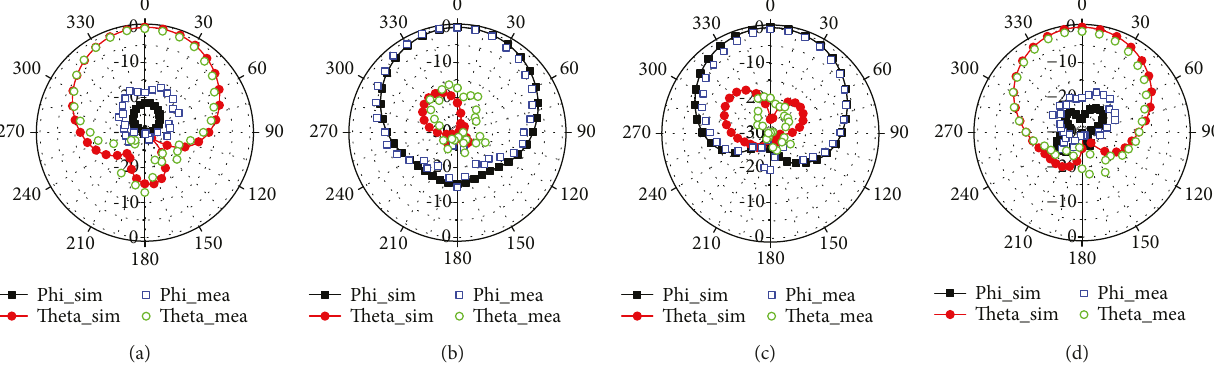
1 , (b) xz -plane at f 1 , (c) yz -plane at f 2 , and (d) xz -plane at f 2 .